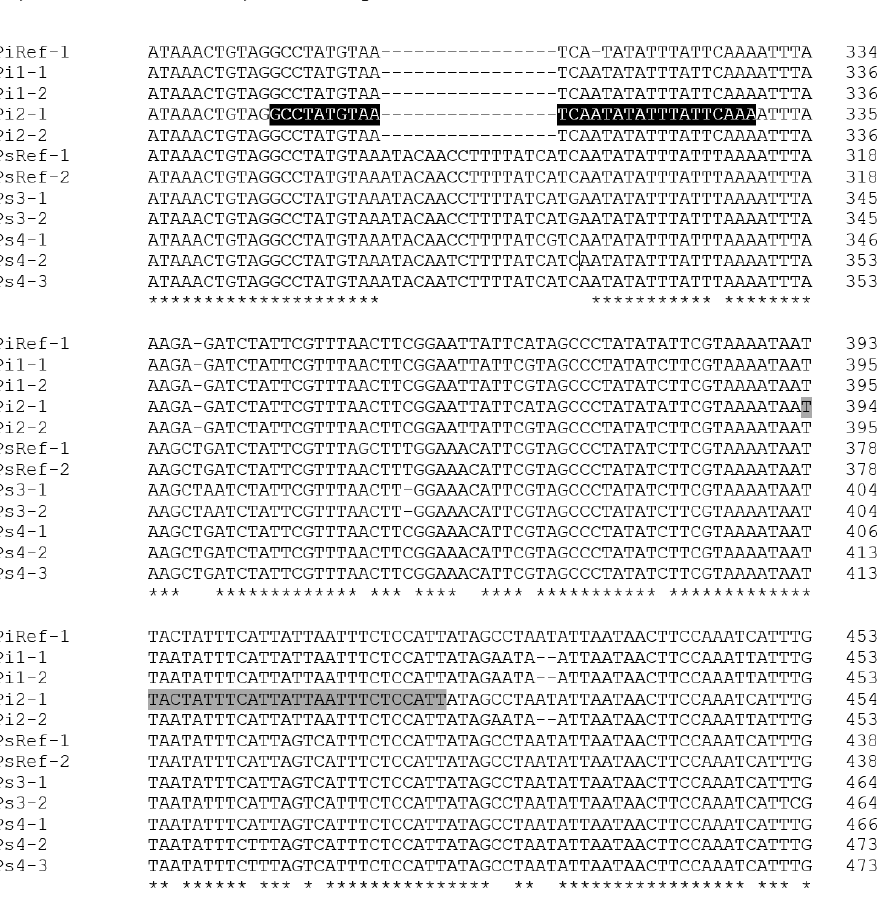
Figure 1. Partial alignment of the intronic regions of nine EF1- α alleles cloned from two P. italosignus (Pi1 and Pi2) and two P. spumarius (Ps3 and Ps4) specimens collected during this study. The homologous sequences of the two alleles of P. spumarius PSPU_08 (GCA_018207615.1) and the only allele of P. italosignus (JF309079) currently available in the Genbank database were included for comparative purposes as PsRef1, PsRef2, and PiRef1, respectively. The positions of the P. italosignus - specific qPCR assay primers, Pital_348F and Pital_465R, are highlighted in black and gray, respectively (the complete alignment of Spit-Uni1/2 products is shown in supplemental material Figure S1). The “*” character indicates positions that are fully conserved.